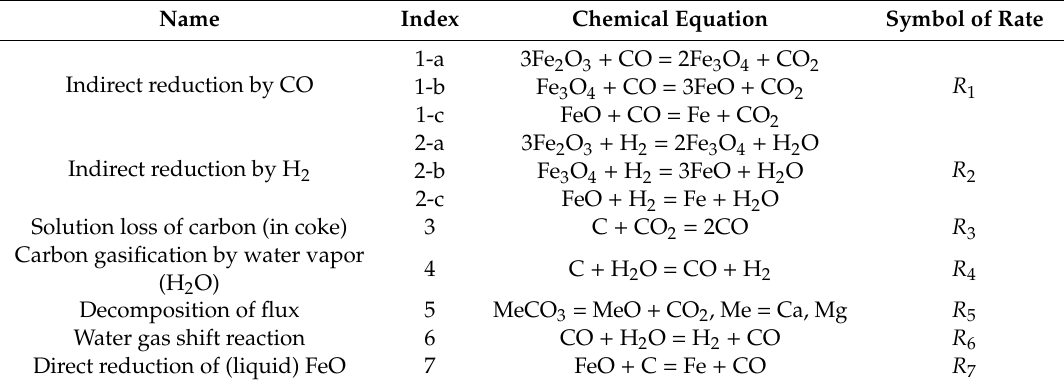
Table 1. Chemical reactions considered in the